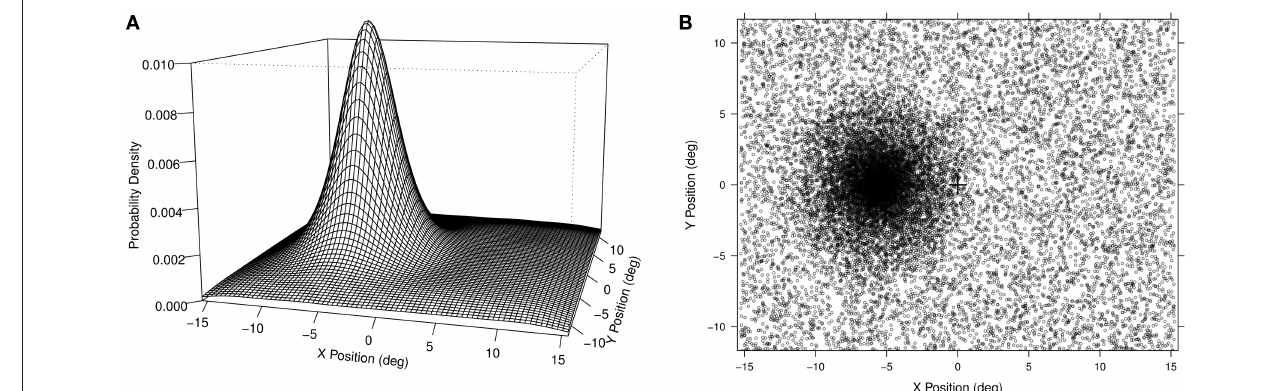
Figure 1 | (A) Left: The probability distribution for the left sided hotspot distribution is shown. The screen dimensions were 31 ° × 24 ° of visual angle and the center of the hotspot distribution was offset 5.6 ° to the left. The distribution had a linear decrease over a radius of 7.3 ° at which point it blended in to